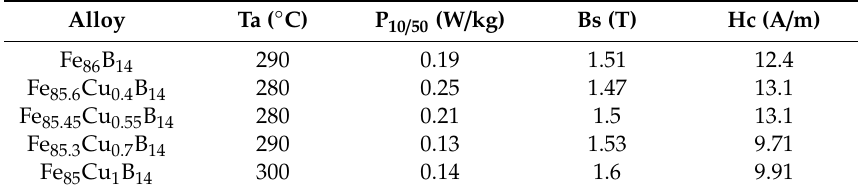
Table 3. Magnetic properties of alloys for optimal